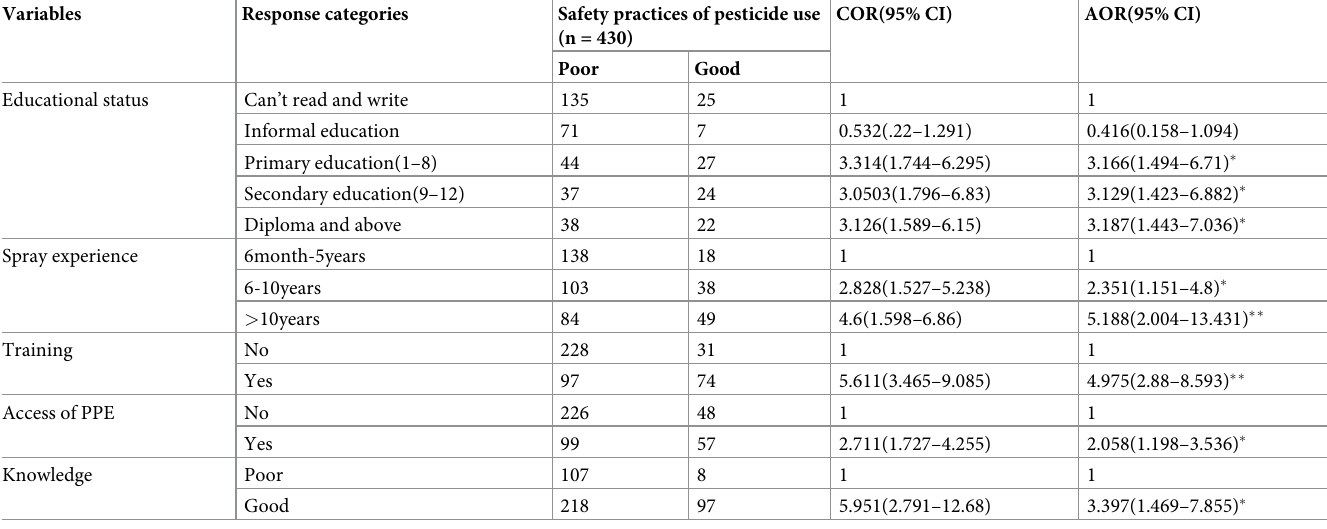
Table 6. Factors associated with pesticide use safety practice showing crude odds ratio and adjusted odds ratio, Fogera district Northwest Ethiopia